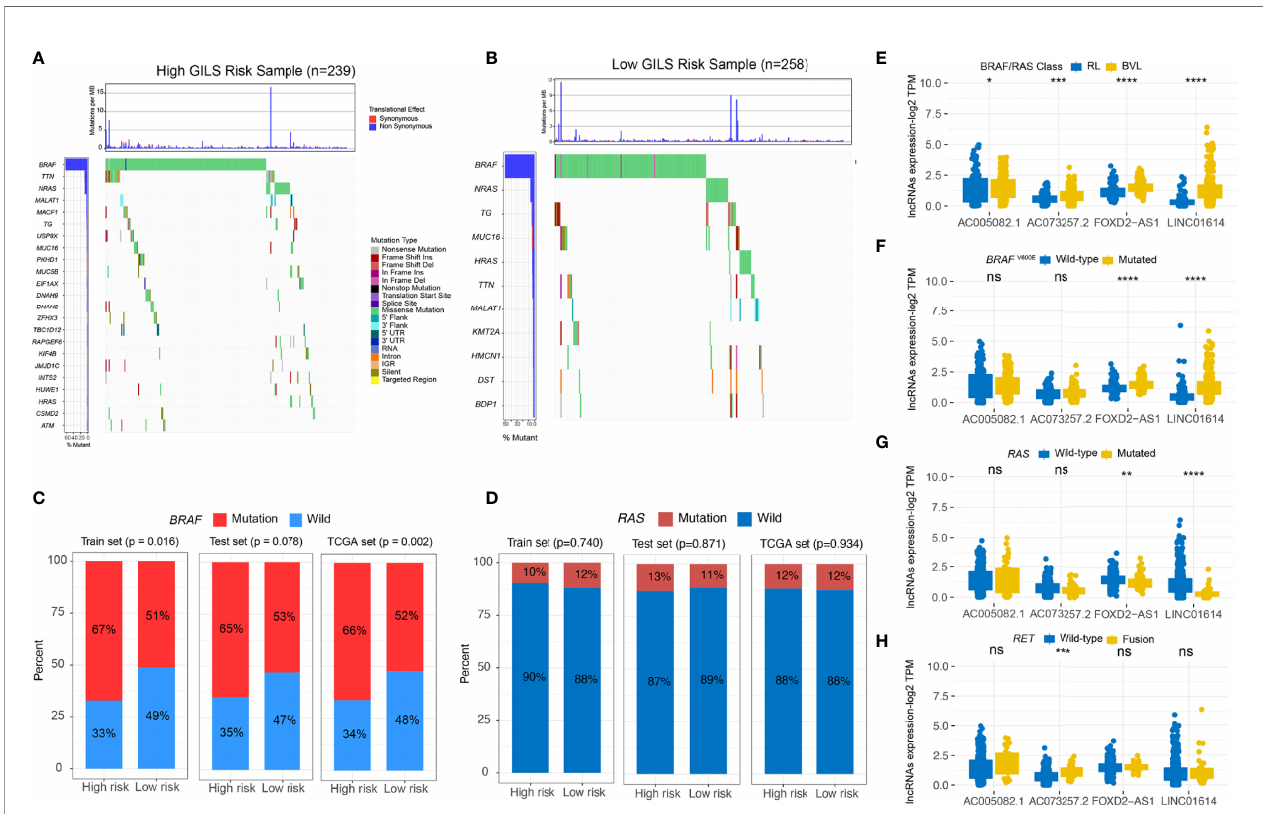
FIGURE 7 | The GILS is related to the molecular characteristics of PTC. (A, B) The general genomic landscape is shown by waterfall plots for the GU- and GS-like groups. The proportion of mutation status of (C) BRAF and (D) RAS in different cohorts. (E – H) GIlncs level in different (E) BRAF/RAS-like phenotype and mutation status of (F) BRAF V600E , (G) RAS , and (H) RET subgroups. ns, no signi fi cance, * p < 0.05, ** p < 0.01, *** p < 0.001, **** p <